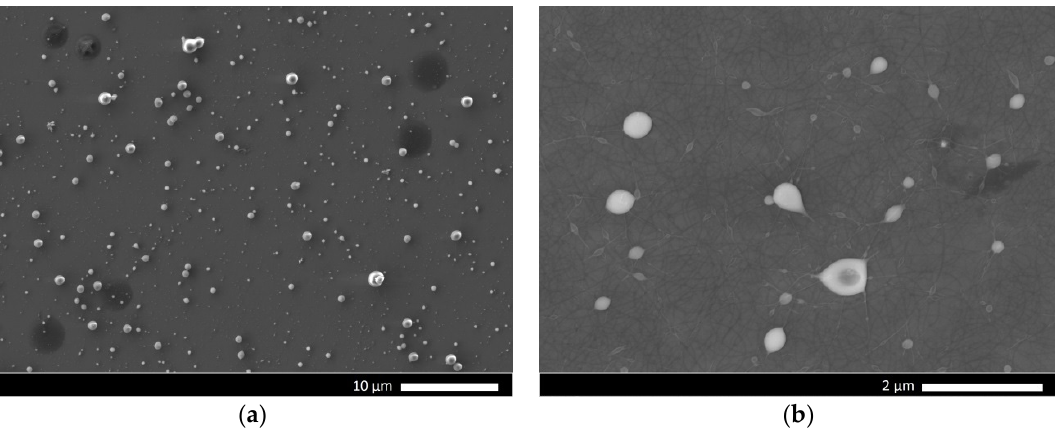
Figure 11. SEM photomicrographs of nanoparticles electrosprayed from the hyaluronic acid solutions with concentration 12.5 mg/mL under 30 kV: ( a ) magnification 4000x; ( b ) magnification 25,000x.